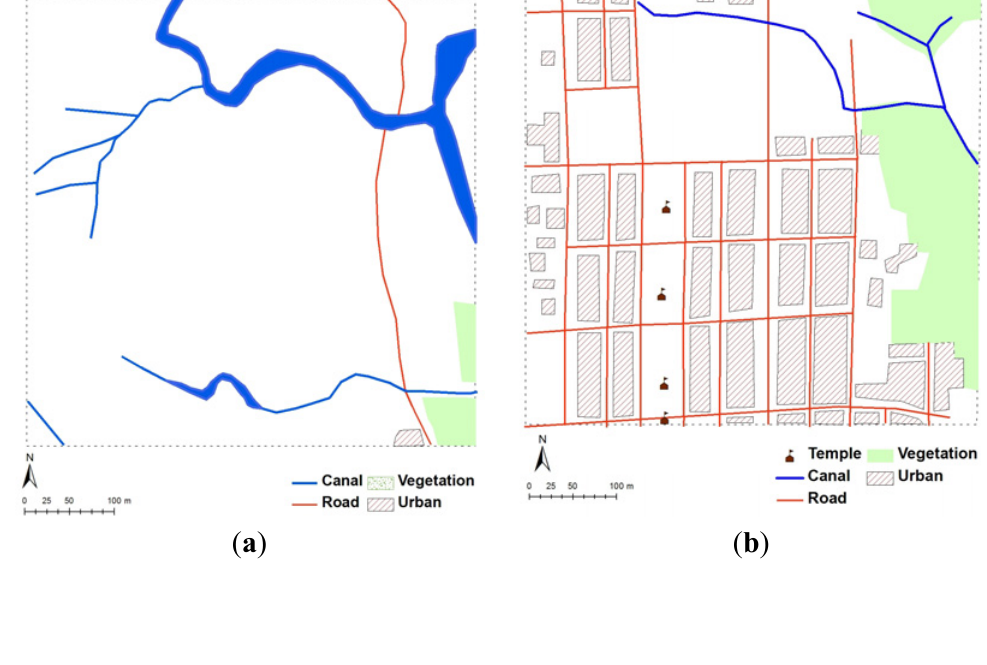
Figure 7. Malleswaram land cover ( a ) 1885; ( b ) 1935; ( c ) 1973; ( d )